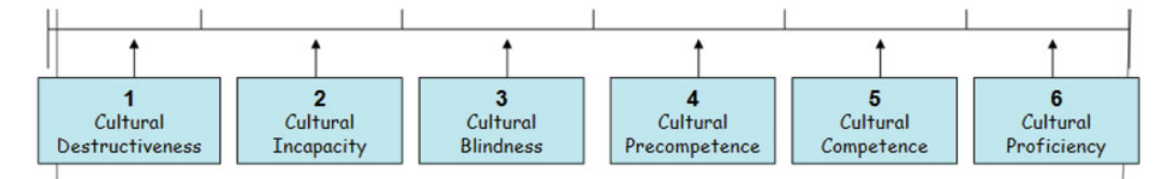
(Colour online) The Inclusion Continuum (Cross et al., 1989). seeking alternative solutions or only making small changes